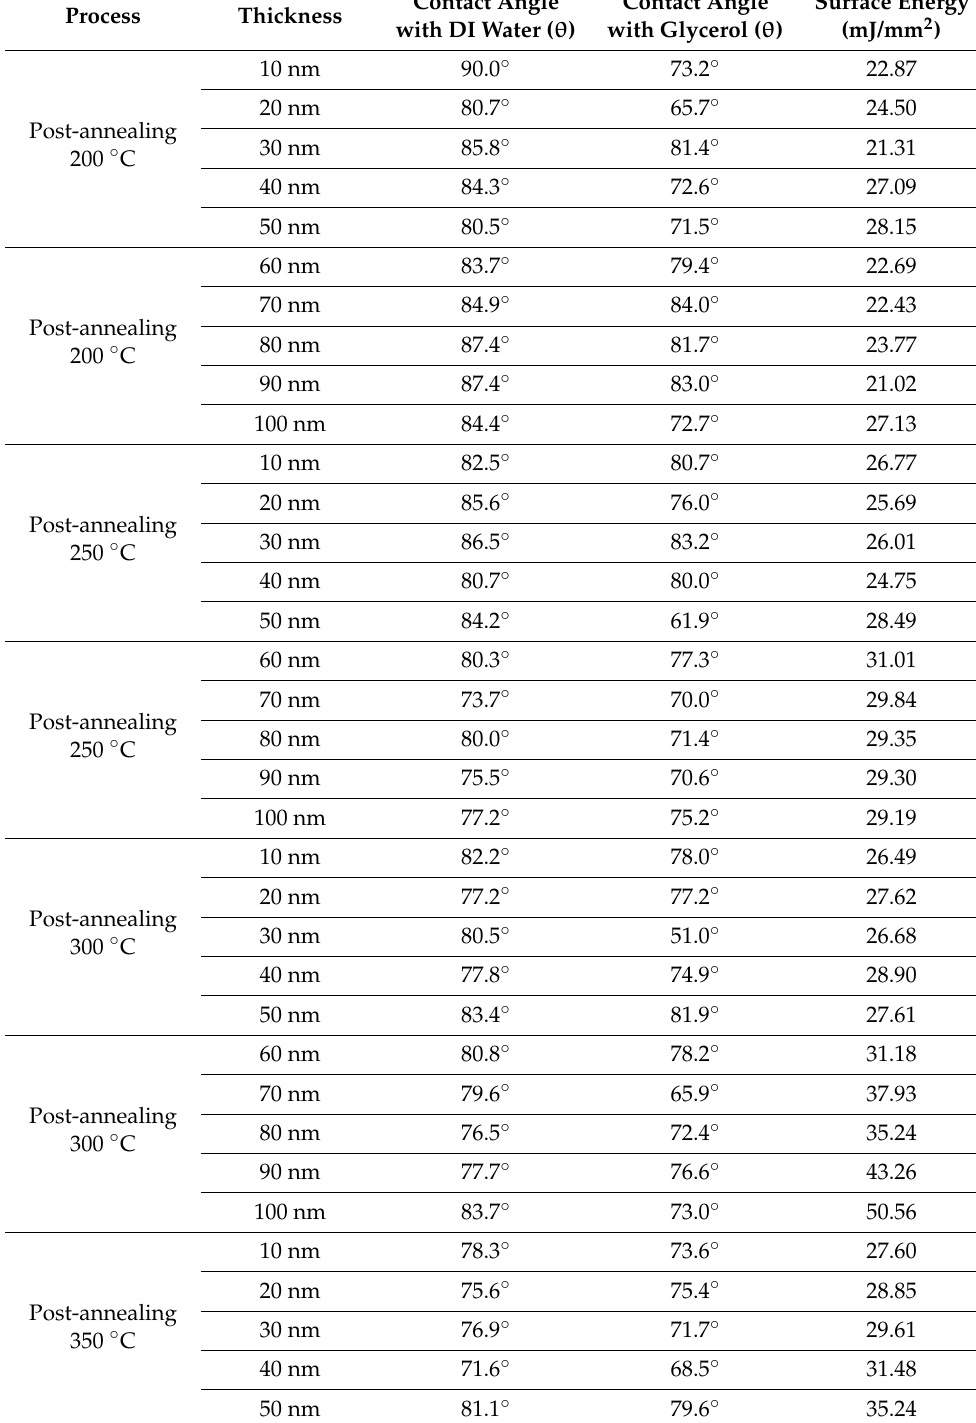
Table 2. Comparing contact angle and surface energy for Co 40 Fe 40 W 10 B 10 thin films from different fabrication processes. Process Thickness